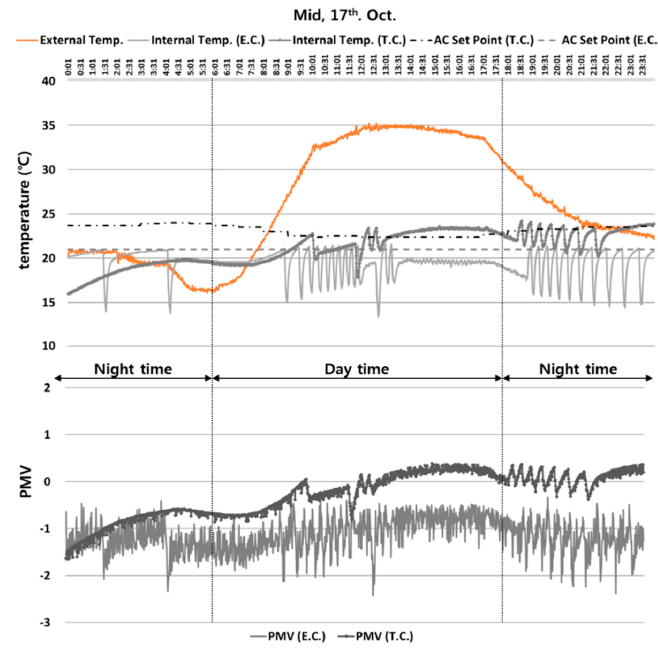
Figure 21. Experimental results recorded on October 17.